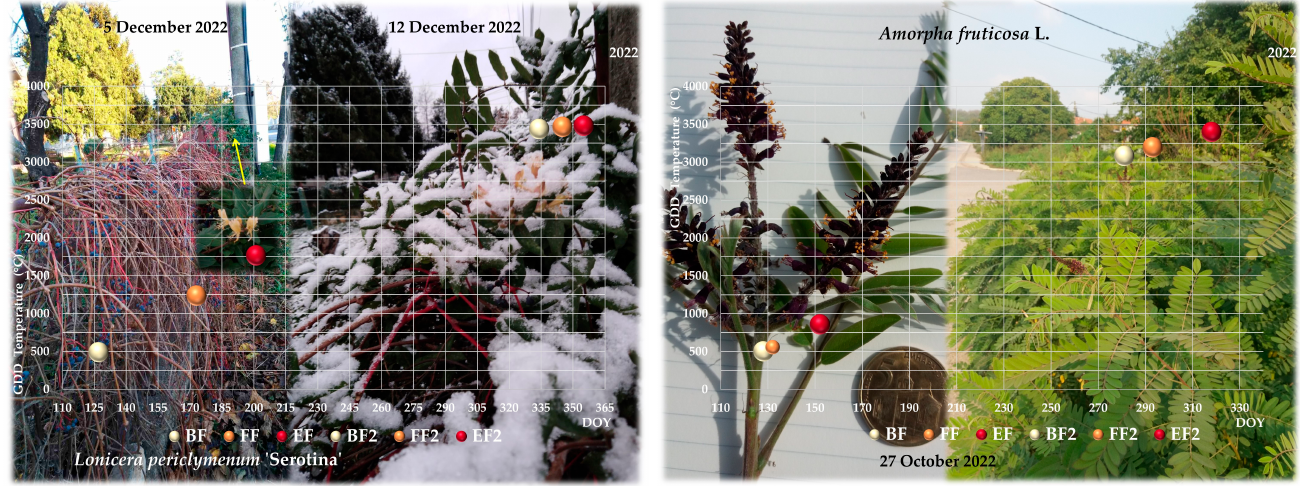
Figure 12. Phenological observations: GDD and DOY for the beginning of first flowering (BF), full first flowering (FF), the end of first flowering (EF), the beginning of second flowering (BF2), full second flowering (FF2), and the end of second flowering for Honeysuckle (left) and Indigo Bush (right) in